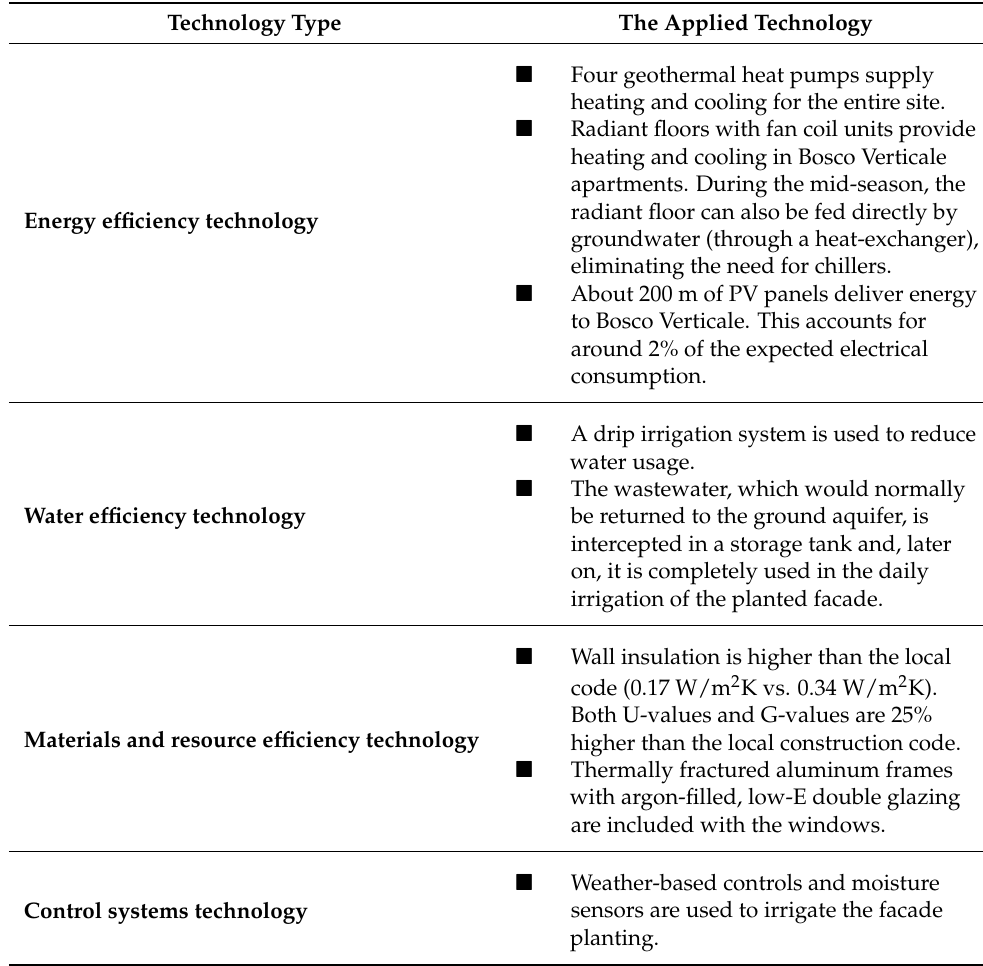
Table 7. Innovative applications of Bosco Verticale